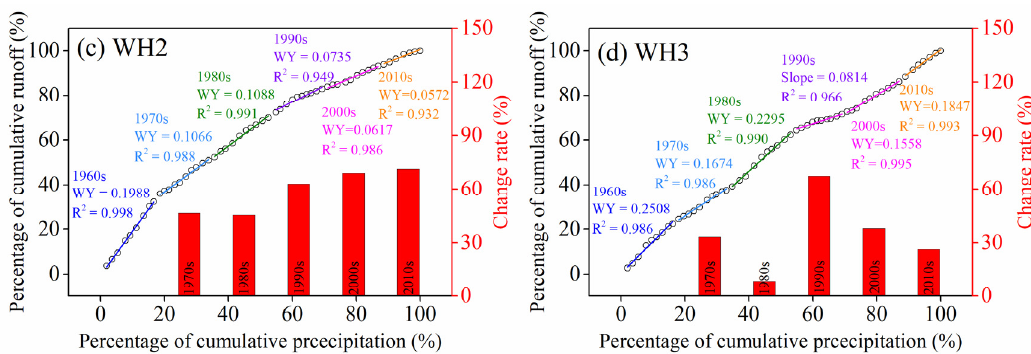
Figure 10. Change of the runoff ratio of ( a ) the Weihe River basin (WH) and the three sub-regions, i.e. ( b ) WH1, ( c ) WH2, and ( d ) WH3, in each decade during 1961–2016 (with the fitted line shown in different colors); the red bars are the decline ratio of freshwater in runoff of each decade compared with that of the 1960s. Precipitation and runoff are accumulated as percentages of the total values during the study period.